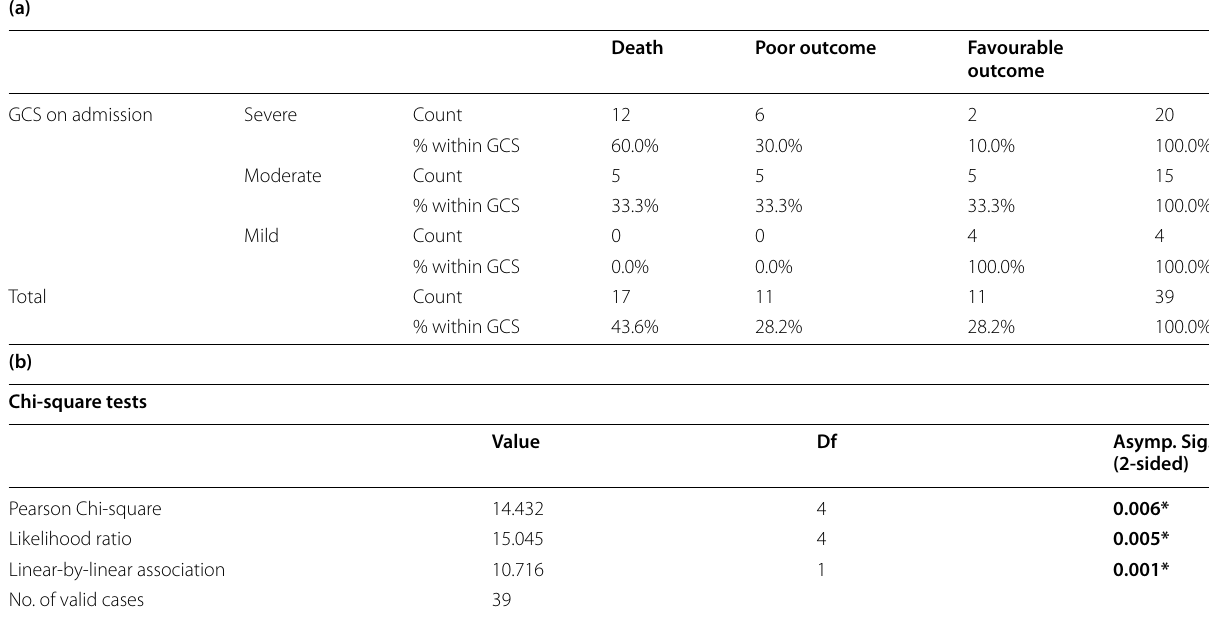
Table 2 Glasgow Outcome Score (GOS) in relation to GCS on admission